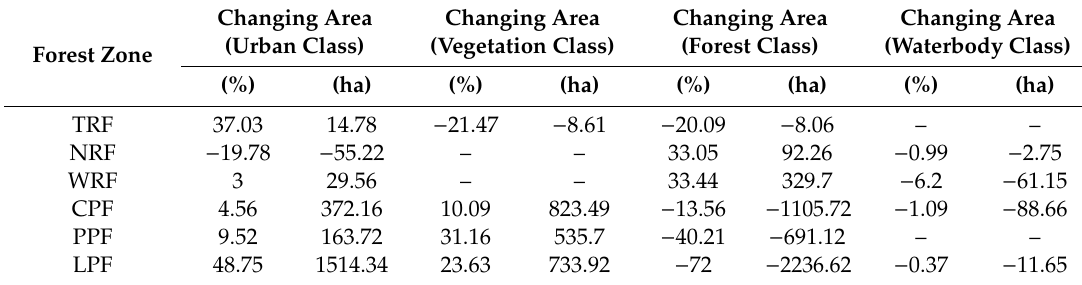
Table 7. Change detection of forest classes from 2003 until 2018.